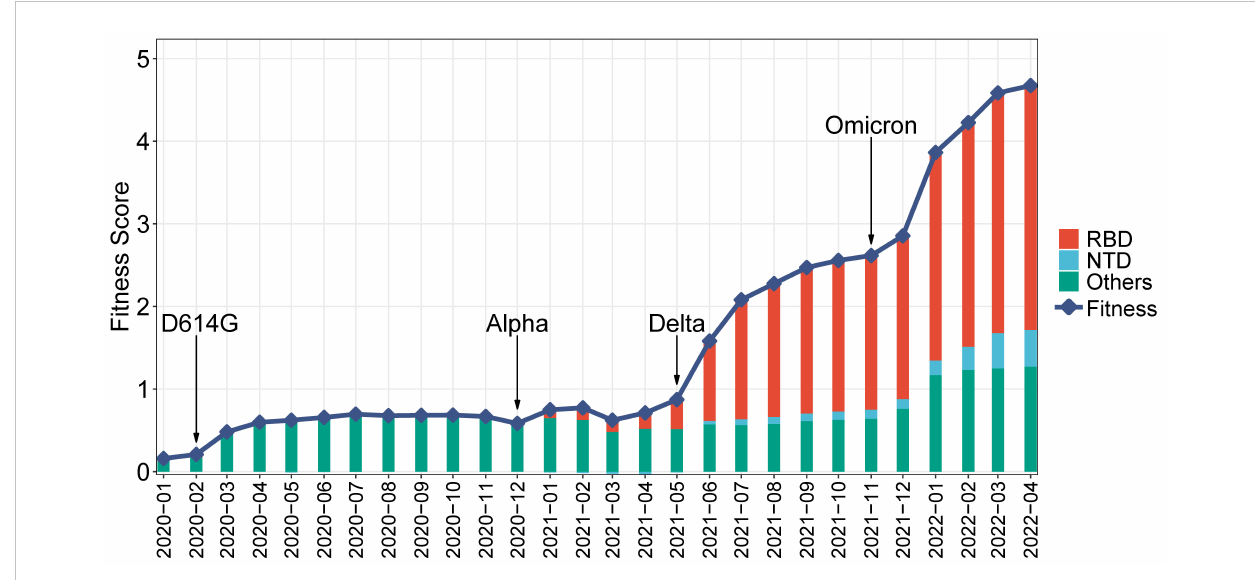
FIGURE 5 Monthly historical fi tness score of SARS-CoV-2. The line represents the historical fi tness score. Stacked bars show the contribution of different Spike regions. The emergence of strains is indicated: the D614G strain, Alpha, Delta, and